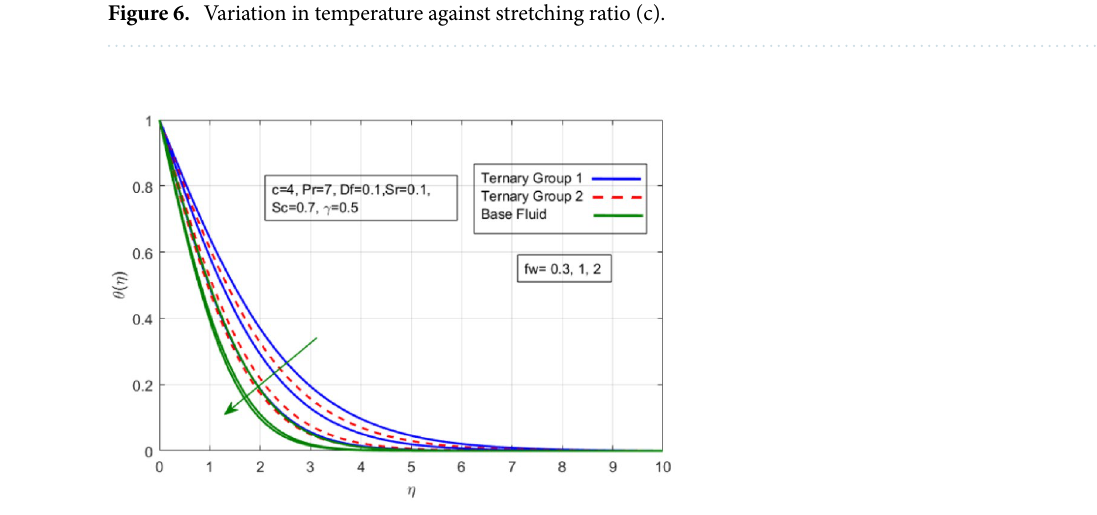
Figure 6. Variation in temperature against stretching ratio (c).